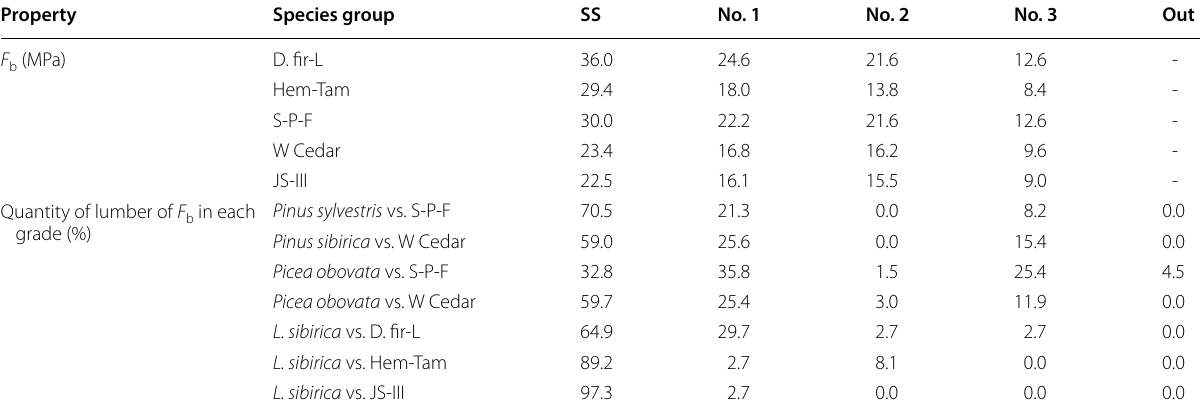
) and quantity of lumber of F b